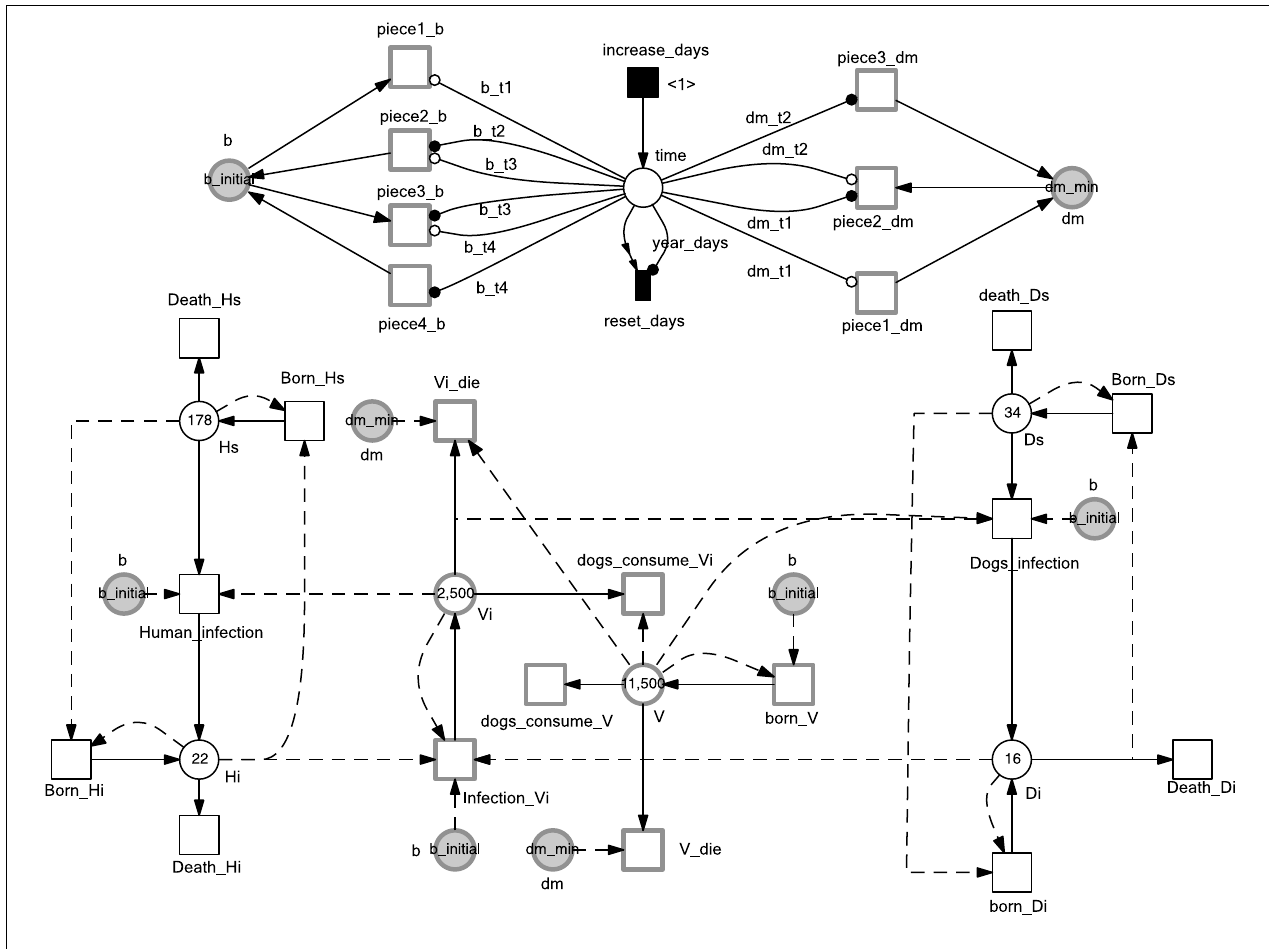
FIGURE 4 | GHPN model of Chagas disease transmission. Continuous and discrete places are used to model the population of vectors and mammals, while continuous transitions are adopted to represent the processes operating on the model species. The simulation time is monitored by the discrete place time which is increased by one time step (one day) when the deterministically delayed transition increase _ days fires. Stochastic and continuous transitions describe